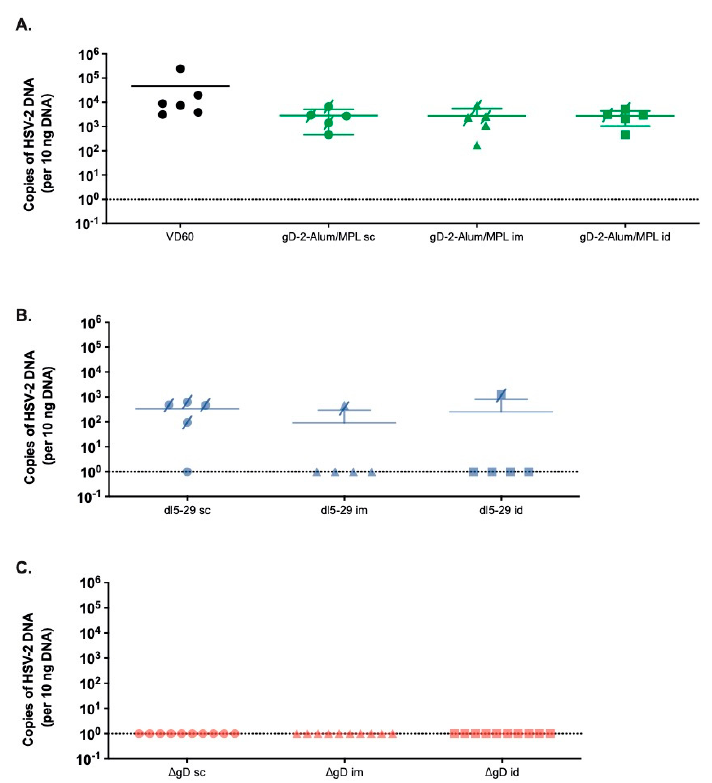
Figure 3. HSV DNA detection in the sacral nerve parallels survival data. Female C57BL/6